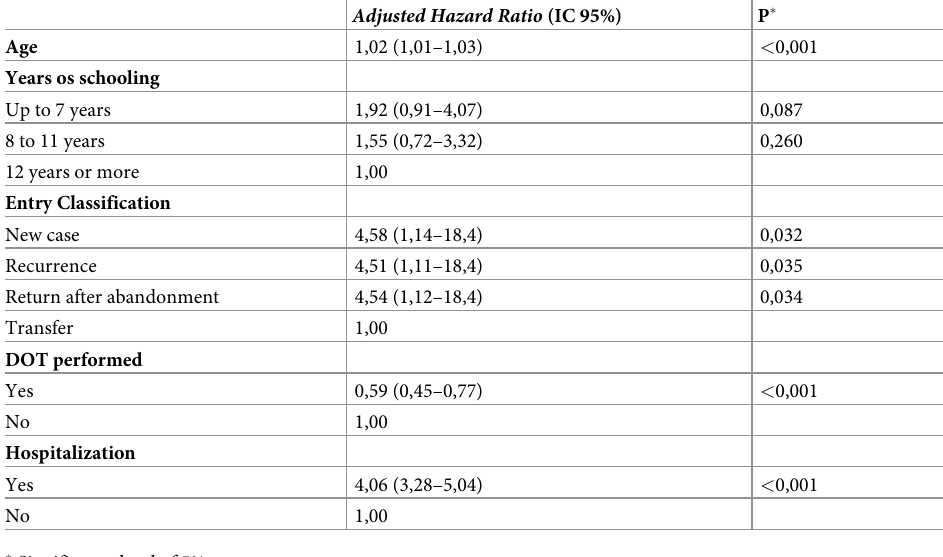
Table 2. Cox regression analysis for cases of TB/HIV coinfection, 2009–2013, Porto Alegre,